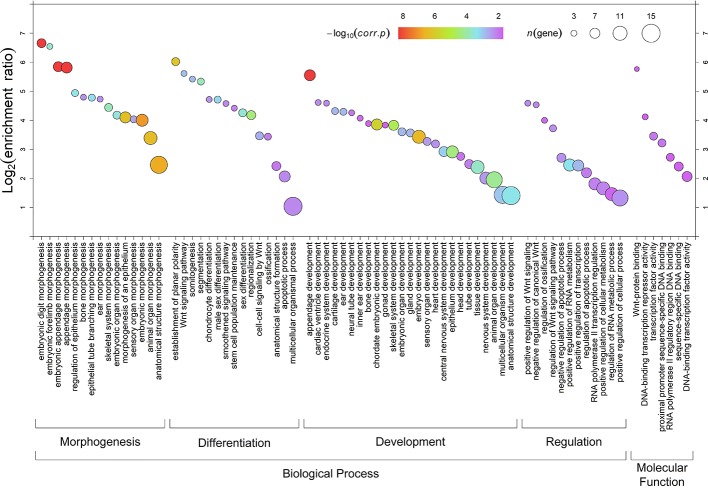
Gene ontology enrichment analysis for 24 face-associated genes.Enrichment of the genes annotating the 24 identified face-associated genes. Enriched terms (FDR < 0.01 and n > 2, x-axis) are indicated by corrected P-value (FDR, different color), candidate genes contained by the terms (n, sizes of dots) and ratio of enrichment between test genes and background genes (y-axis).